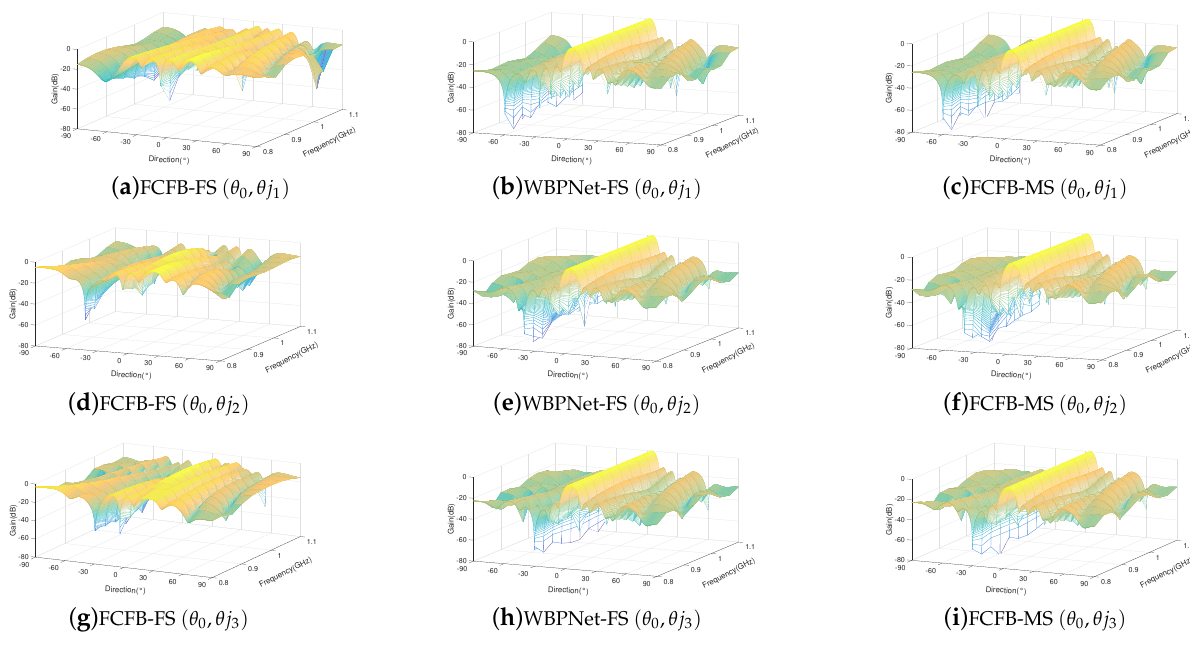
Figure 4. Beampatterns of randomly selected pairs angles with different snapshots.